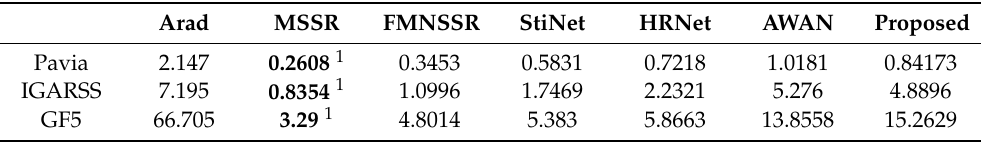
Table 5. Time complexity comparison for different methods (unit: second).